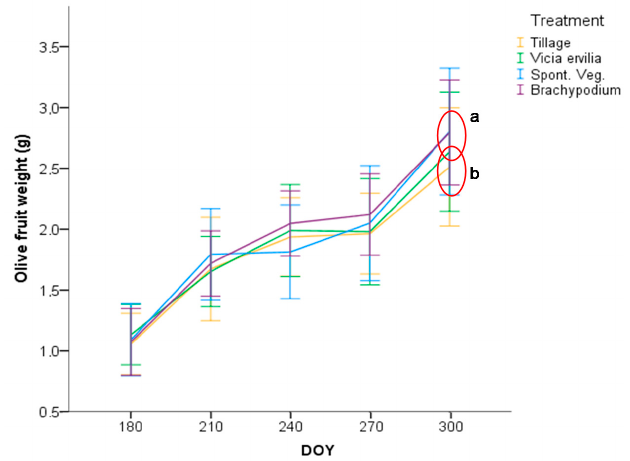
Figure 10. Olive fruit weight evolution across the crop season 2016 / 2017 for the four treatments. Statistically significant differences between treatments at p < 0.05 according to Tukey’s test (N = 40) were marked with a red ring and different letters.